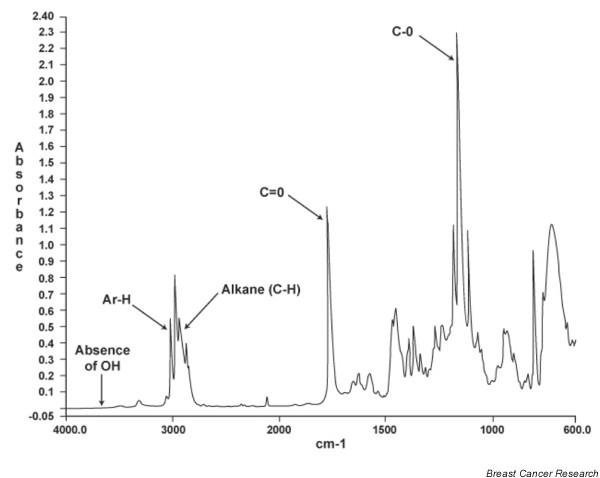
Characterization of propofol-docosahexaenoic acid conjugate by infrared spectroscopy. The infrared spectrum of the conjugate was recorded on a Perkin Elmer/2000 FT-IR. The sample was run as a thin film after evaporation of solvent. The broad, strong absorption bands at 1,750 cm-1 and 1,250 cm-1 are attributable to C=O and C–O bonds, respectively, and indicate the presence of an ester. The band at 3,030 cm-1 is characteristic of an aromatic C–H (propofol) and the band at 2,800 to 2,960 cm-1 is characteristic of aliphatic C–H bonds. No O–H absorption band was seen, indicating the absence of nonesterified propofol.